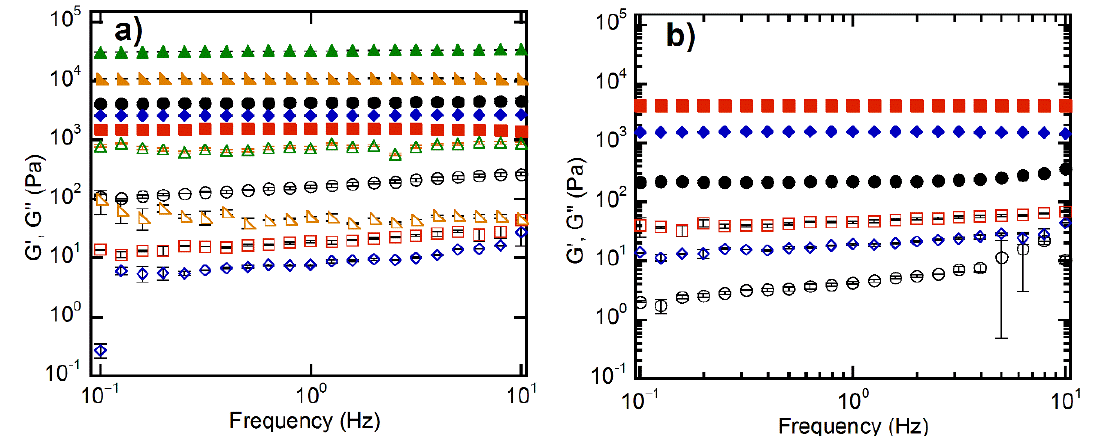
Figure 9. Frequency sweep rheological measurements of the hydrogel samples synthesized. ( a ) The effect of crosslinker type. HMBA 4 ( ● , ○ ); HDVE 4 ( ◆ , ◇ ); HXLG 10 ( ■ , □ ); HMBA 4 -XLG 10 ( ▲ , △ ); HDVE 4 -XLG 10 ( ◣ , ◺ ) . ( b ) The effect of XLG concentration. HXLG 5 ( ● , ○ ); HXLG 10 ( ◆ , ◇ ); HXLG 15 ( ■ , □ ). G' = full symbols; G" = empty symbols.